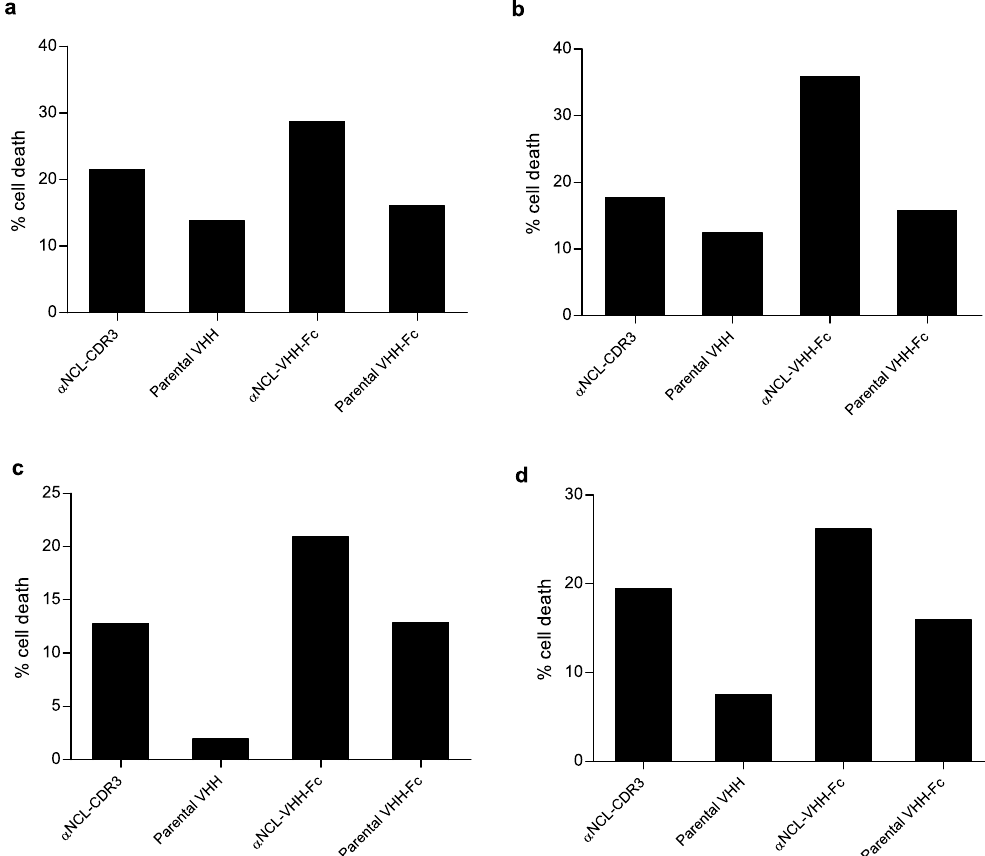
Figure 6. Effect of the PBMCs donor variability on the cytotoxicity of nucleolin-binding proteins against MDA- MB-435S cells. Figures a–d represent the cytotoxicity assays, performed in duplicate, with PBCMs harvested from four donors, using the xCELLigence system. MDA-MB-435S, previously cultured in a RTCA plate for 24 h, were incubated with PBMCs (at a target cells/effector cells ratio of 1:10 or 1:5) and 25 nM anti-nucleolin VHH-Fc antibody ( α NCL-VHH-Fc) or the parental VHH-Fc antibody, without the nucleolin-binding component, for 72 h at 37 °C. The VHH counterparts of these antibodies (50 nM α NCL-CDR3 VHH or parental VHH) were also included as controls. Cancer cell death was calculated from the area under the curve (AUC), as described in the Methods. Differences in cytotoxicity among the tested proteins, upon incubation with PBMCs, were evaluated by repeated measures ANOVA followed by Tukey